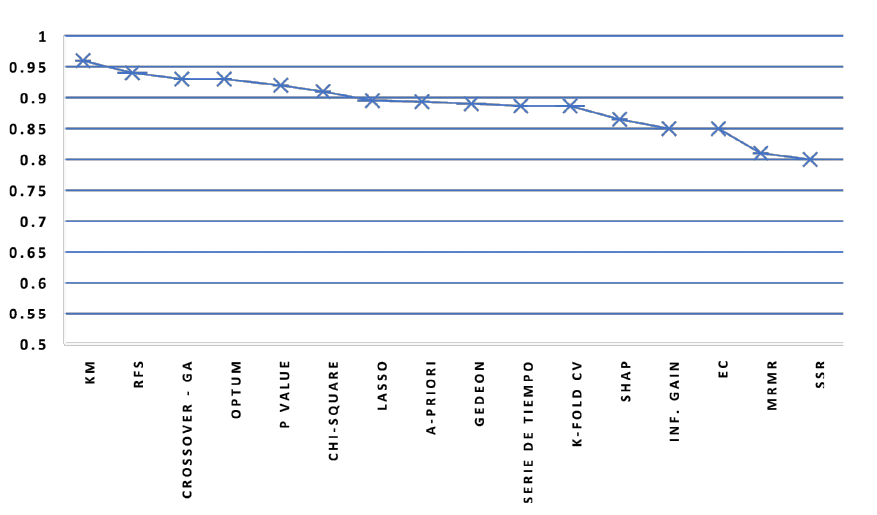
Figure 4. The average performance of algorithms based on the feature selection technique.